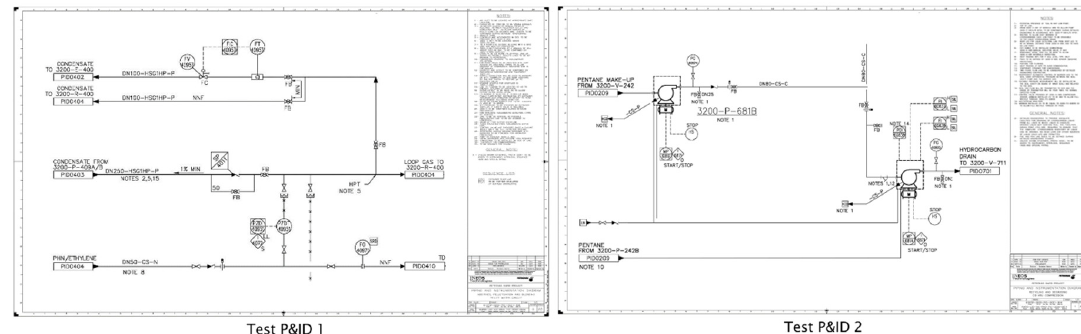
Figure 12. P&IDs used for the experiments.